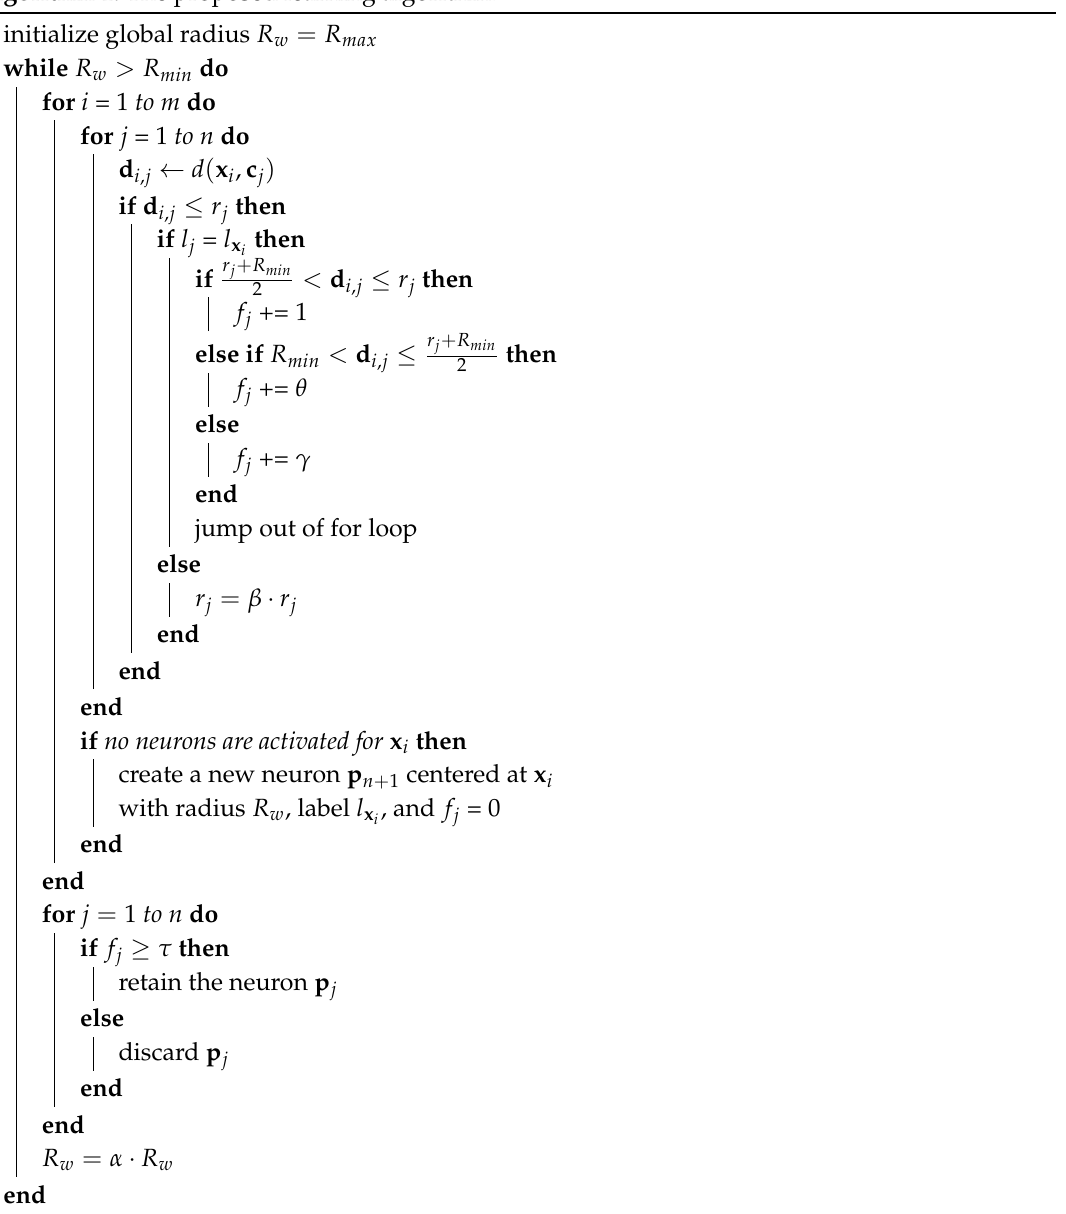
Algorithm 1: The proposed learning